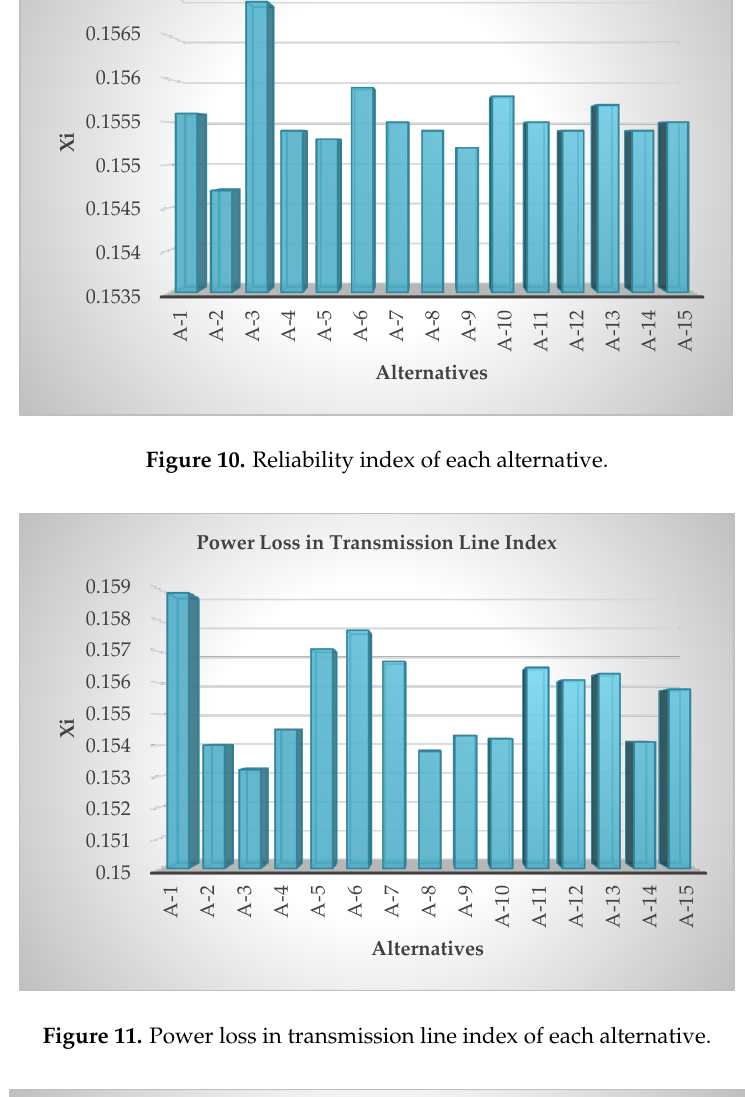
Figure 13. CO 2 Emission index of each alternative.